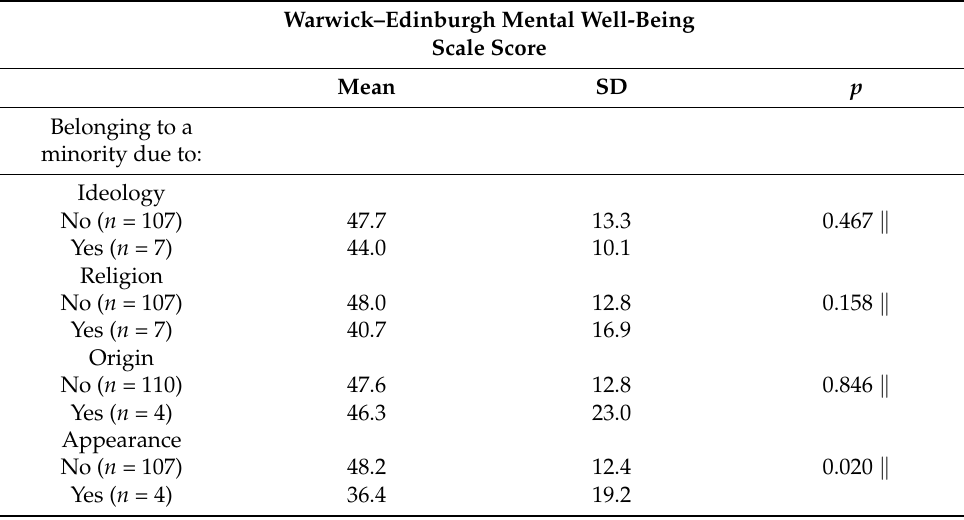
Table 3. Associations concerning minorities and discrimination with mental